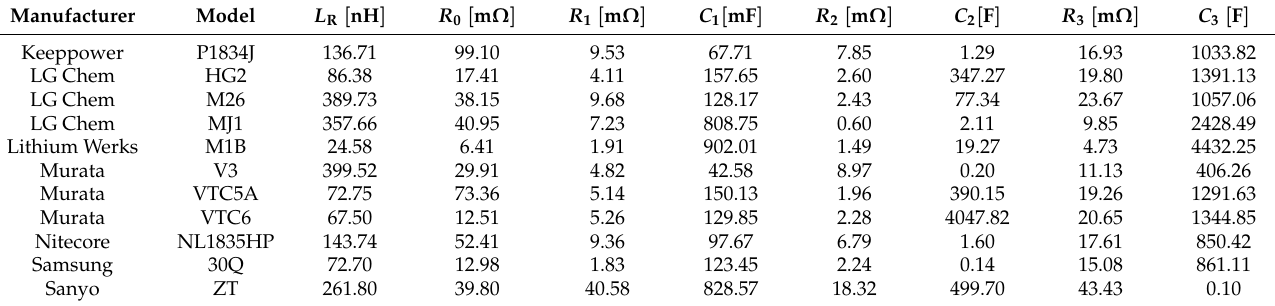
Table 3. Estimated battery parameters for the three- RC -pair model.